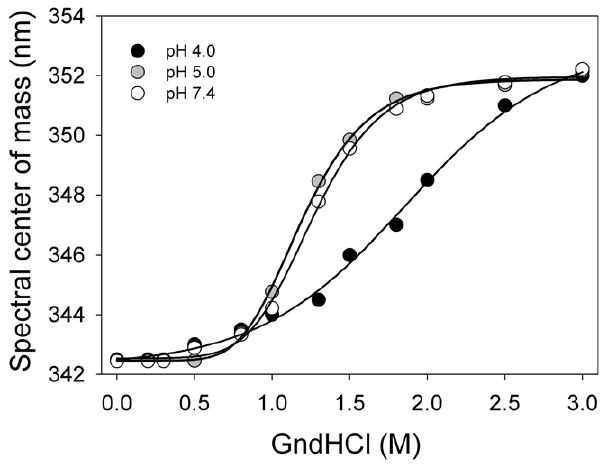
Figure 1. Equilibrium unfolding of apoA-I at different pHs . Spectral centers of mass of the intrinsic fluorescence emission of apoA-I are plotted as a function of [GndHCl]. Final protein concentration was 0.1 mg/mL; excitation was at 295 nm and emission was recorded between 310 and 420 nm. Experiments were performed at pH 4.0 (black), pH 5.0 (gray), or pH 7.4 (white symbols). Lines are fits to the data using a sigmoideal model.